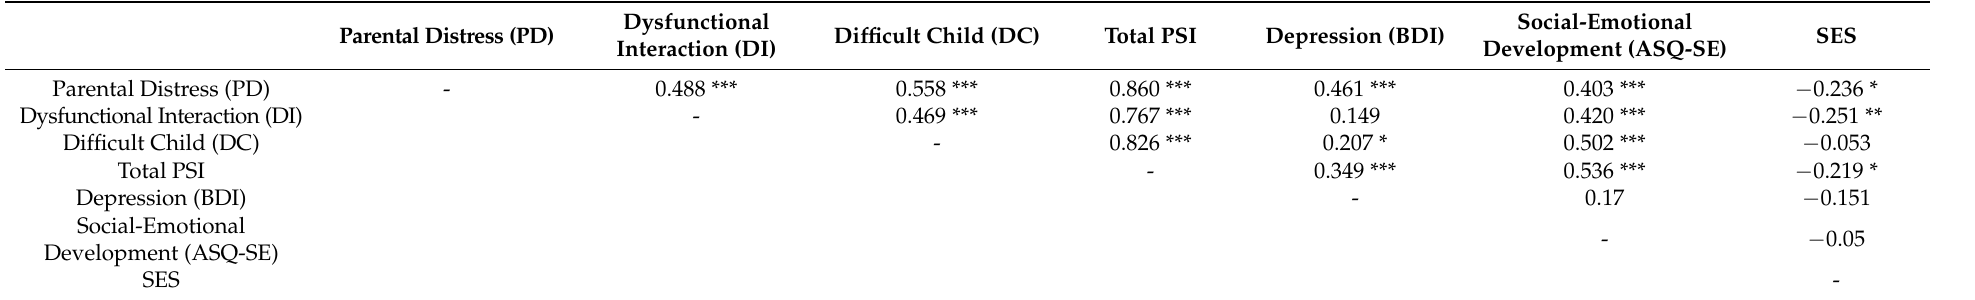
Table 3. Correlation between depression, parental stress and child social-emotional development.